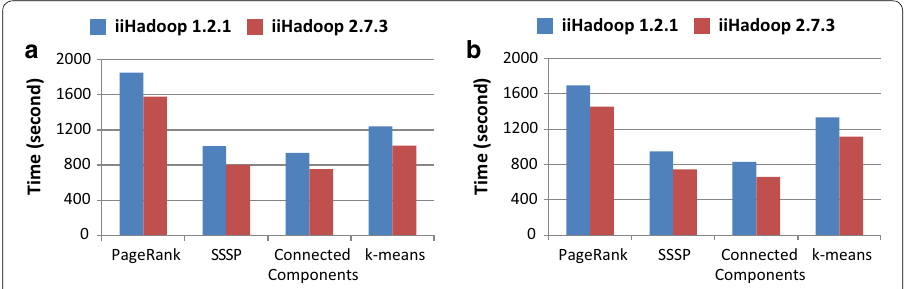
Fig. 6 Total running time of iiHadoop on YARN. a Iterative processing. b Incremental